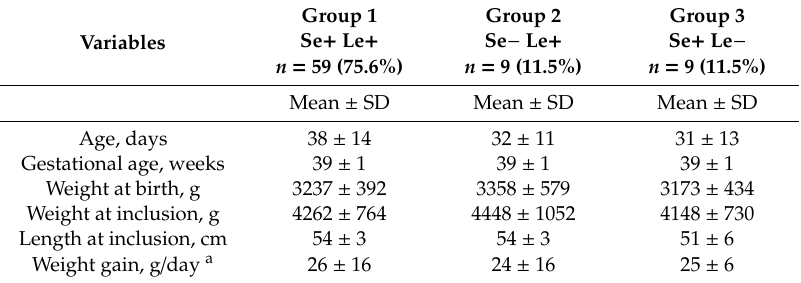
Table 3. Descriptive characteristics of the infants according to the Secretor and Lewis phenotypes of their